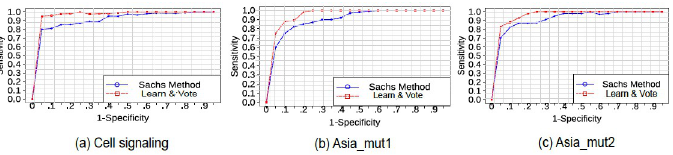
Fig 6. Sensitivity vs. FPR for “Learn and Vote” and the Sachs et al. method on three datasets: (a) Sachs et al. cell signaling; (b) Asia lung disease (mut1); and (c) Asia lung disease (mut2). The line plots are non-monotonic due to the use of different random initial DAGs for different points on the line